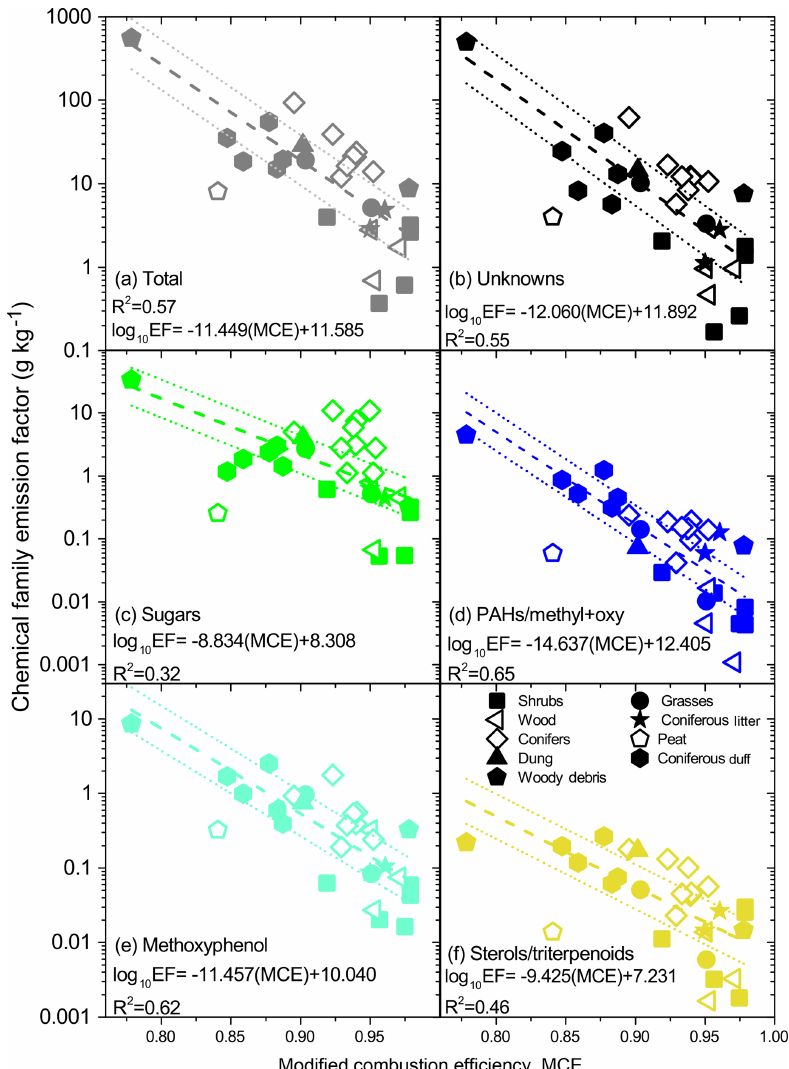
Figure 4. Summed emission factors (EFs) within a chemical family for each burn as a function of modified combustion efficiency (MCE). Each panel depicts a different family with (a) total observed I/SVOC EF, (b) unknowns, (c) , sugars, (d) polycyclic aromatic hydrocarbons (PAHs, including methylated and oxygenated forms), (e) methoxyphenols, and (f) sterols/triterpenoids. Dashed lines represent a log fit of the form log(EF) inversely proportional to MCE. The dotted lines represented a factor of 2 above and below the model. Symbols denote different fuel